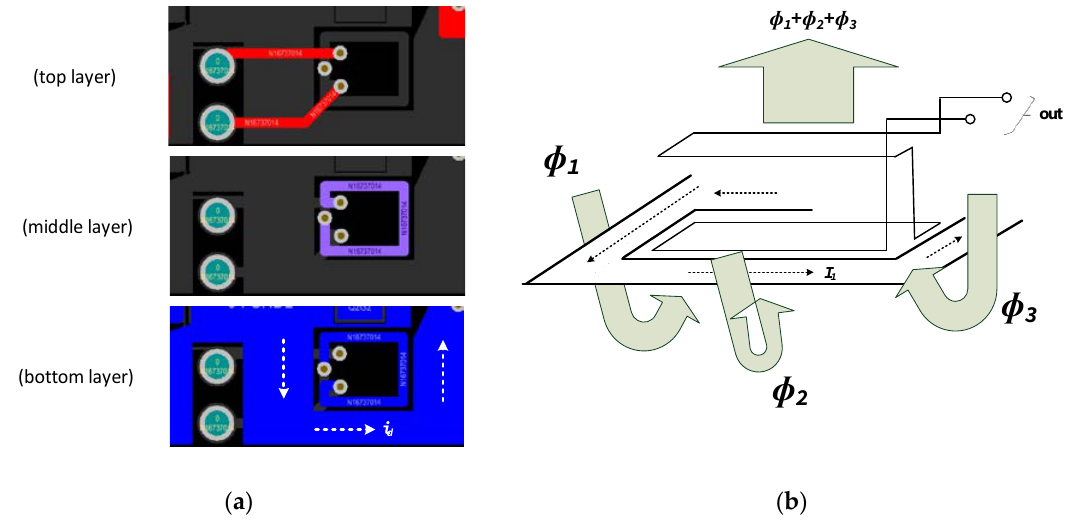
Figure 5. Proposed sensor coil structure: ( a ) description of the proposed coil; ( b ) PCB layout.